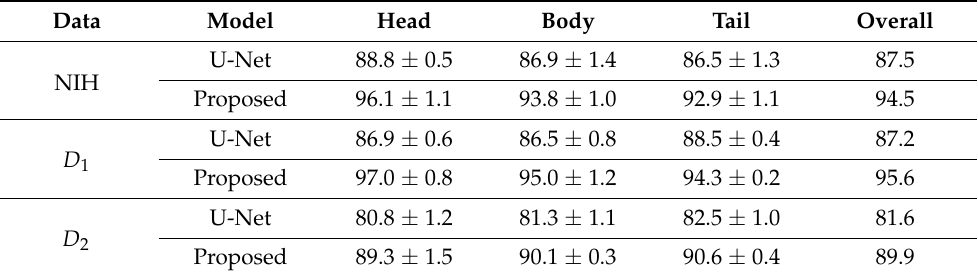
Table 1. All values represent percentage DSC . ‘Proposed’ refers to the integration of the U-Net with the Bayesian model. Best performance across all datasets is shown in bold. Data Model Head Body Tail Overall NIH